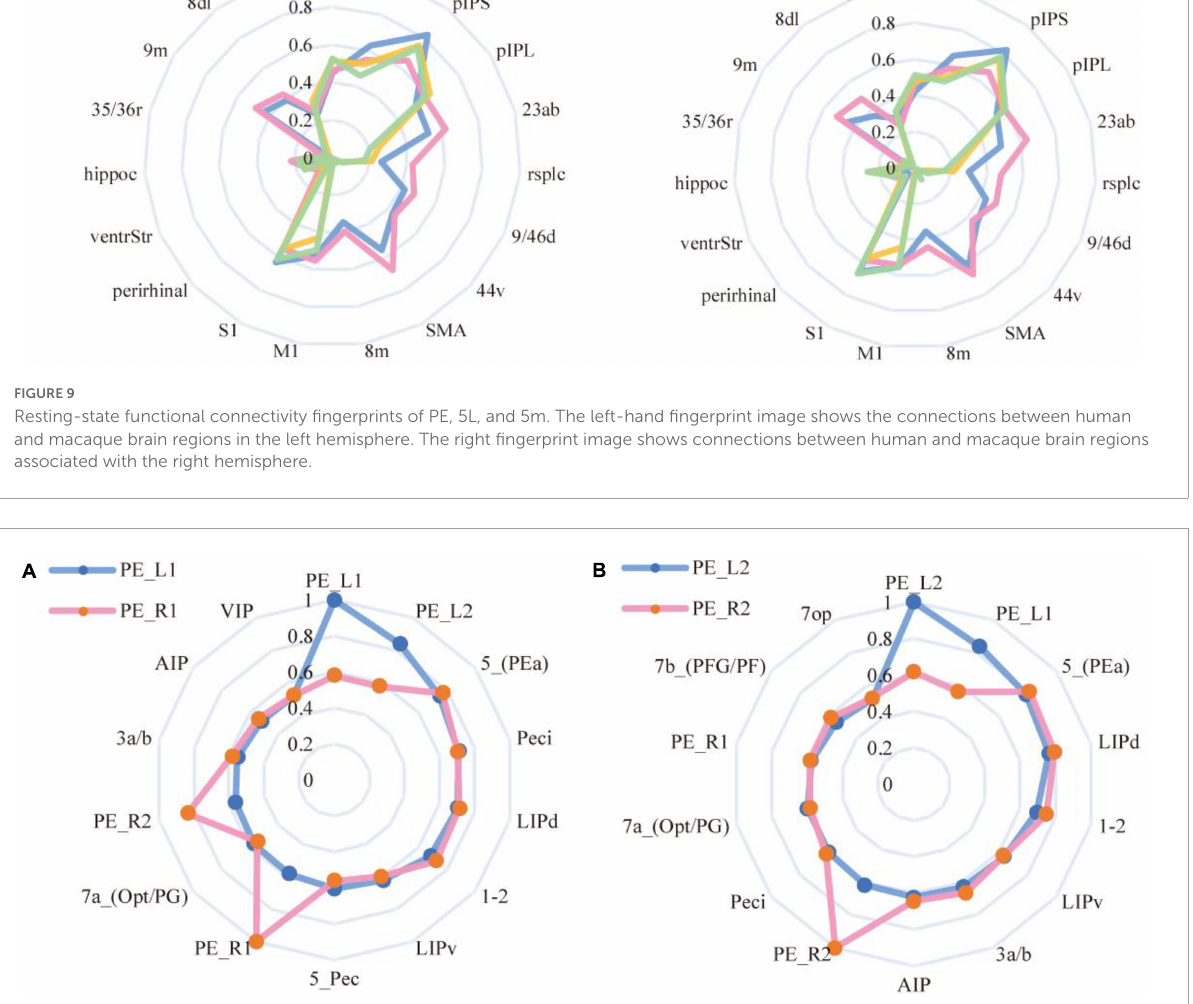
FIGURE10 Resting-state functional connectivity fingerprinting of PE subregions. (A) The fingerprint shows the related brain regions connections with bilateral hemispheres of the macaque brain PE_1 area. (B) The fingerprint shows the related brain regions connections with bilateral hemispheres of the macaque brain PE_2